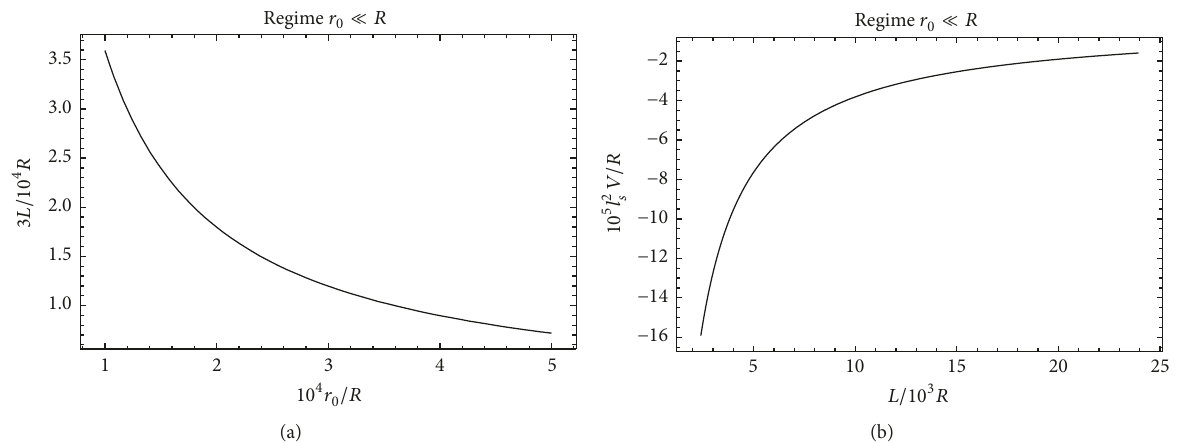
Figure 3: Behaviour of the separation distance 𝐿 against 𝑟 0 /𝑅 and the potential 𝑉 against 𝐿/𝑅 in the regime 𝑟 0 ≪ 𝑅 . (a) Monotonic decreasing behaviour of 𝐿/𝑅 versus 𝑟 0 /𝑅 . (b) Nonconfining potential interaction 𝑙 2 𝑠 𝑉/𝑅 versus 𝐿/𝑅 . Here, in both panels 𝑟 1 /𝑅 = 10 5 and 𝑟 0 /𝑅 < 5 × 10 −4 for the D3 branes.